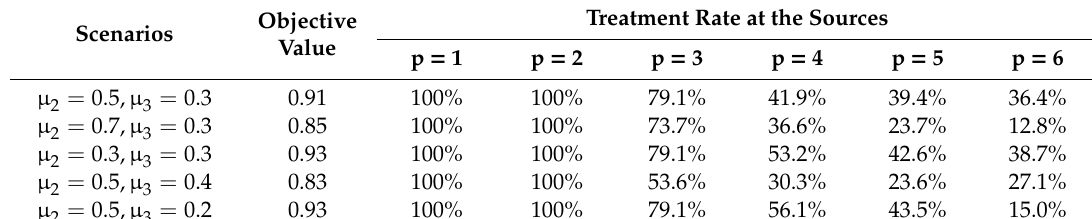
Table 10. Comparison of the objective value and treatment rate of medical waste at the sources in each period.